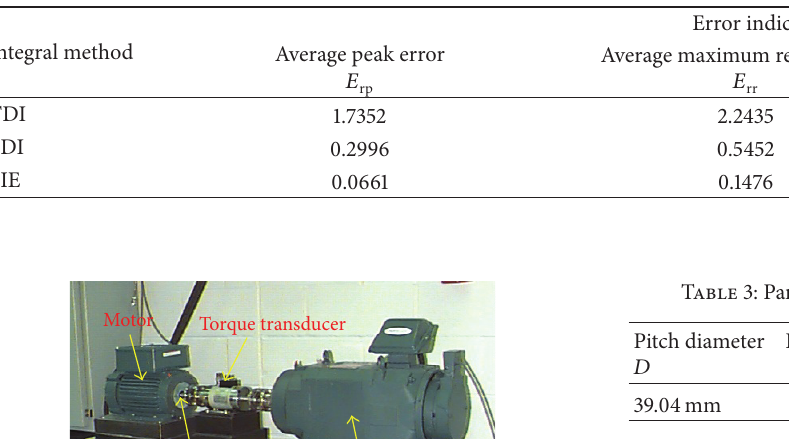
Table 2: Error comparison of integral displacement.